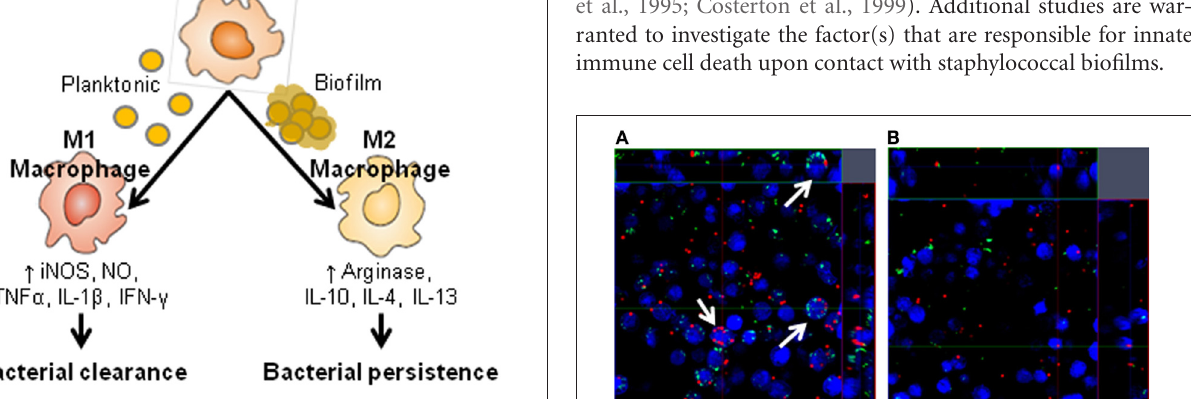
FIGURE 4 | Phagocytosis is impaired in response to S. aureus biofilms. Bone marrow-derived macrophages labeled with CellTracker Blue (blue) were incubated with (A) fresh medium or (B) biofilm-conditioned supernatants for 2h, whereupon planktonic S. aureus expressing GFP (green) and fluorescent latex beads (red) were added for 1h to determine macrophage phagocytic ability by confocal microscopy. Arrows indicate phagocytic